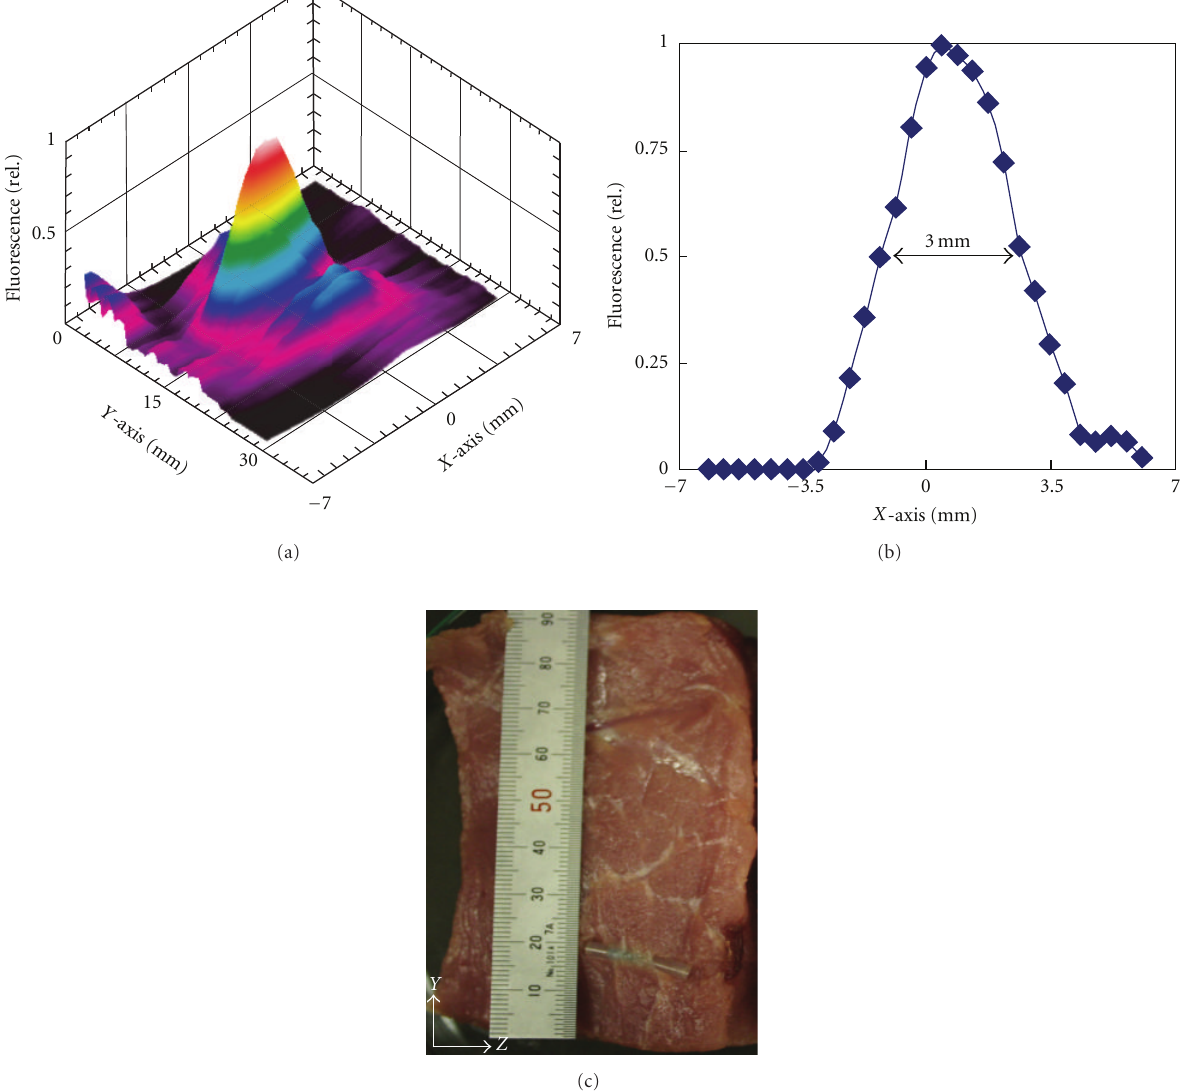
Figure 4: (a) The 2D cross-sectional image of fluorescent object within the tissue sample. (b) The X -profile of the image at peak point after using the threshold filter. (c) Picture of the section of the sample to show the buried fluorescent